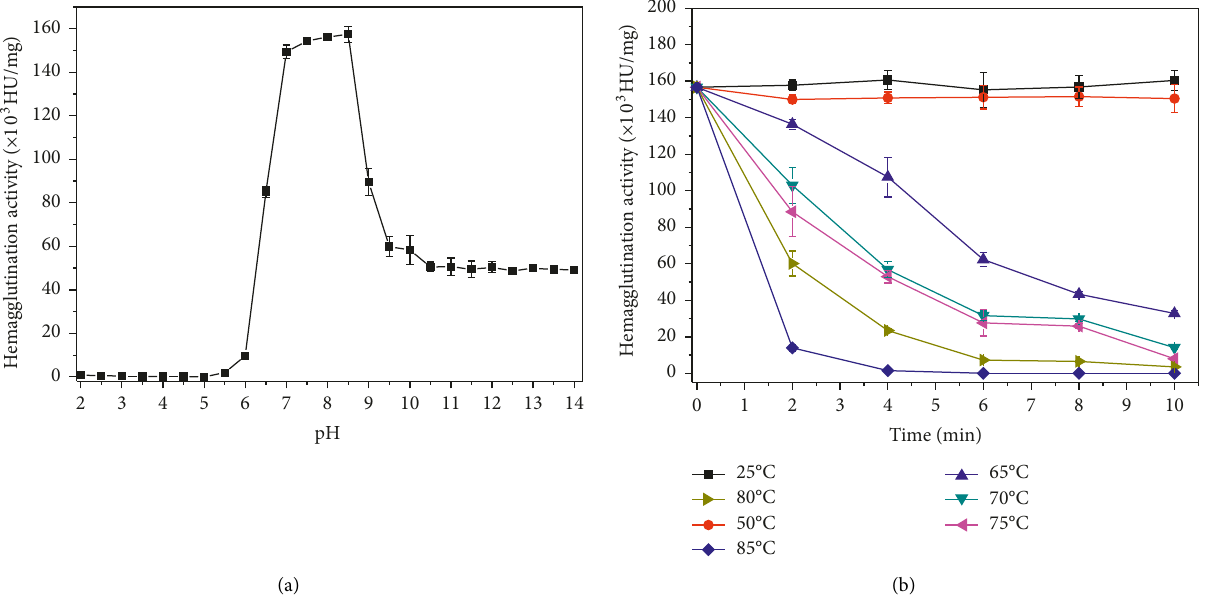
Figure 4: Effect of pH (a) and temperature (b) on hemagglutination activity of